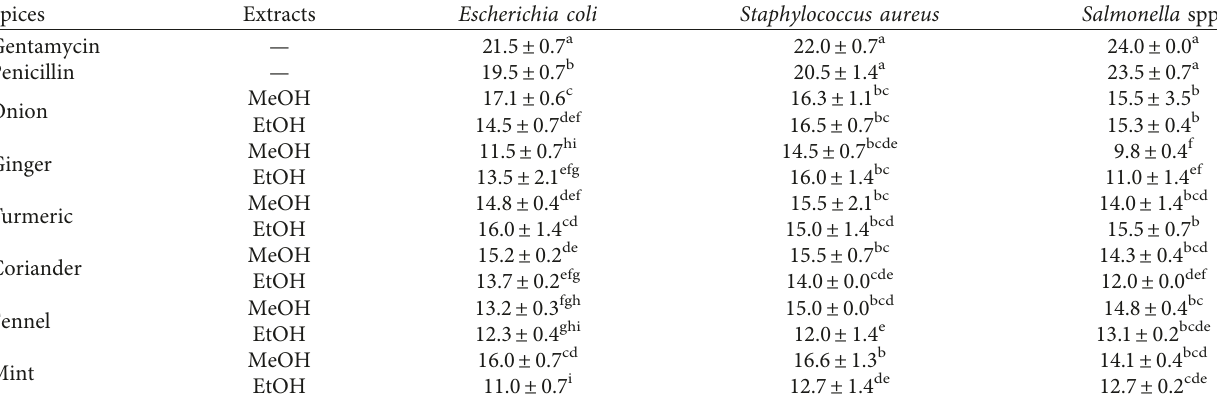
Table 4: Antimicrobial activity of spice extracts against various pathogenic microbes at 150ppm concentration.